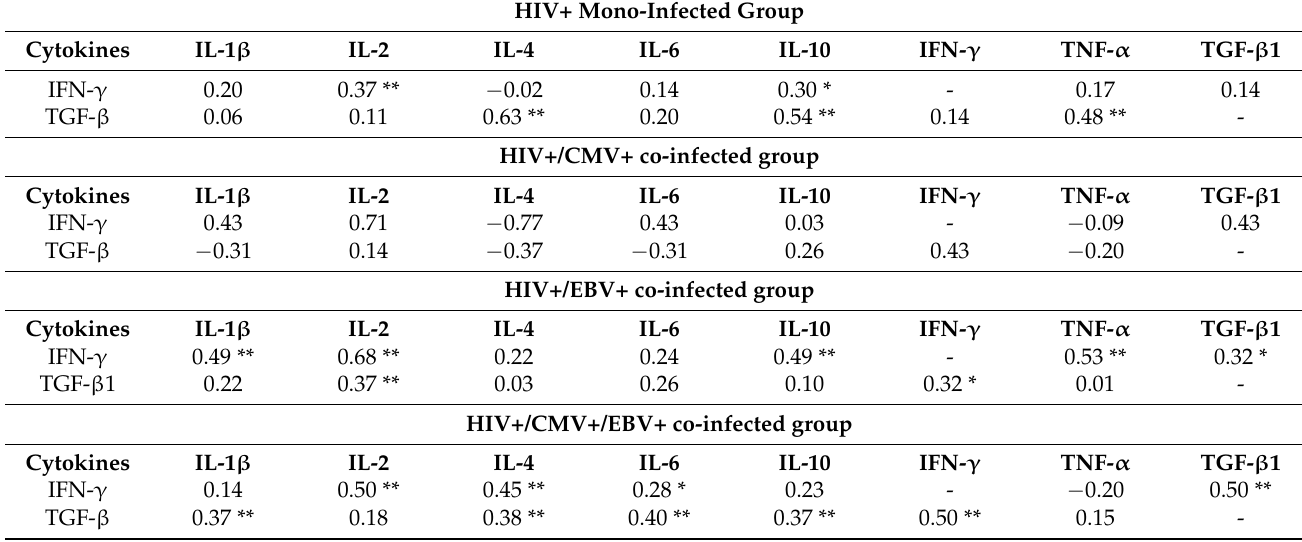
Table 3. Correlation of eight cytokines in HIV mono- and co-infected groups. Each column shows the R-value (the coefficient of correlation). Correlations with p < 0.05 are indicated with * and p < 0.01 are indicated with **.